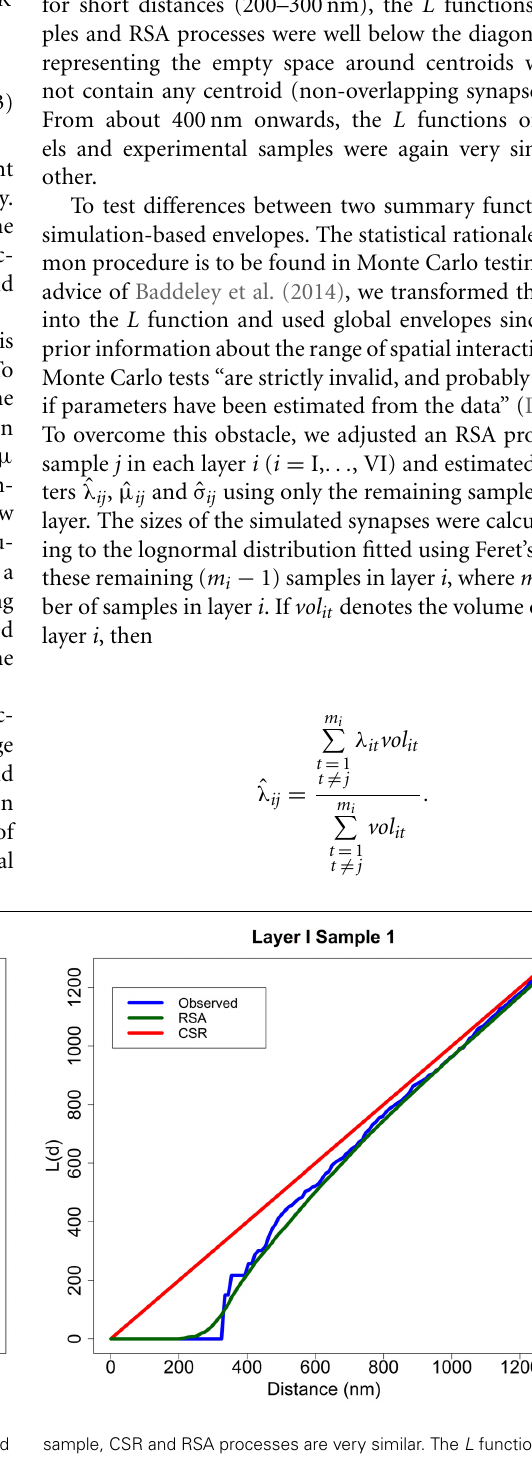
sample, CSR and RSA processes are very similar. The L functions of the RSA and the experimentally observed sample are positioned well below the diagonal (CSR) for short distances and are fairly close to the diagonal for larger